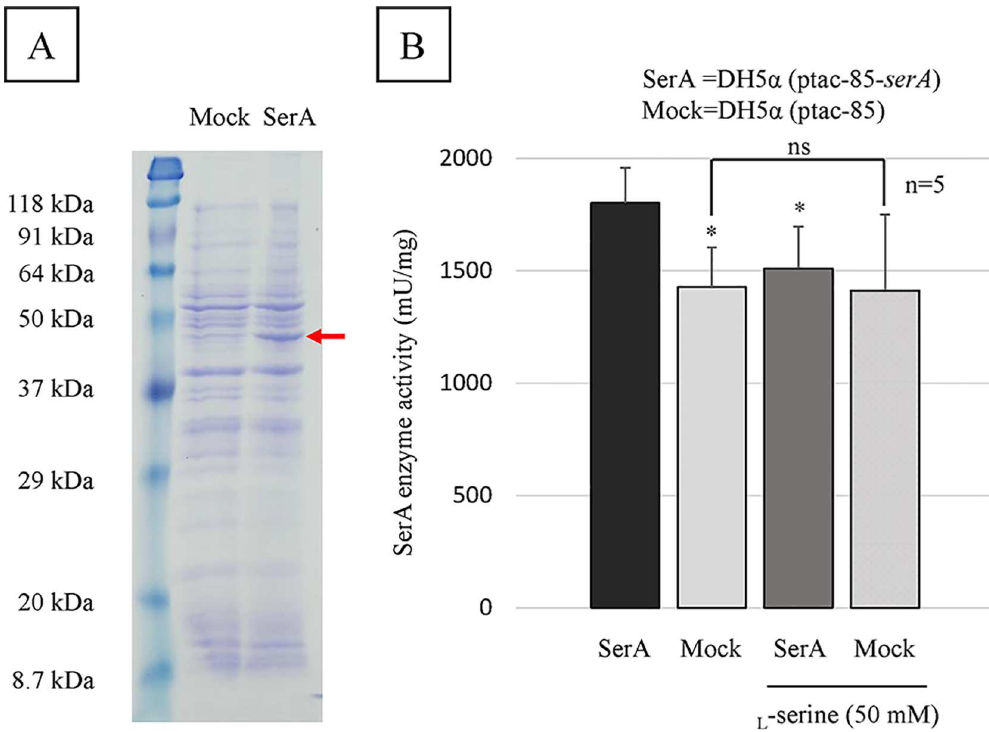
Fig 8. PGDH activity assay. (A) SDS-PAGE analysisto verify overexpression of the P . aeruginosa serA and synthesis of SerA proteins in crude extract isolatedfrom DH5 α (ptac-85- serA ) culture (SerA) and from DH5 α (ptac- 85) culture (mock). The red arrow indicatesan overexpressed band at the expected size of 44 kDa for P . aeruginosa SerA. (B) Inhibitory effect of 50 mM L -serine on PGDH activity of SerA proteins (mU/mg) in crude extract isolatedfrom DH5 α (ptac-85- serA ) culture (SerA) and from DH5 α (ptac-85) culture (mock). The assay was performed in five replicates, and the results are expressedas the mean ± SD. Significantdifferences were observed betweenSerA and mock ( * : P < 0.05), and betweenSerA and SerA in the presenceof 50 mM L -serine ( * : P < 0.05). There was no significantdifference betweenmock and mock in the presenceof 50 mM L -serine (ns: P >